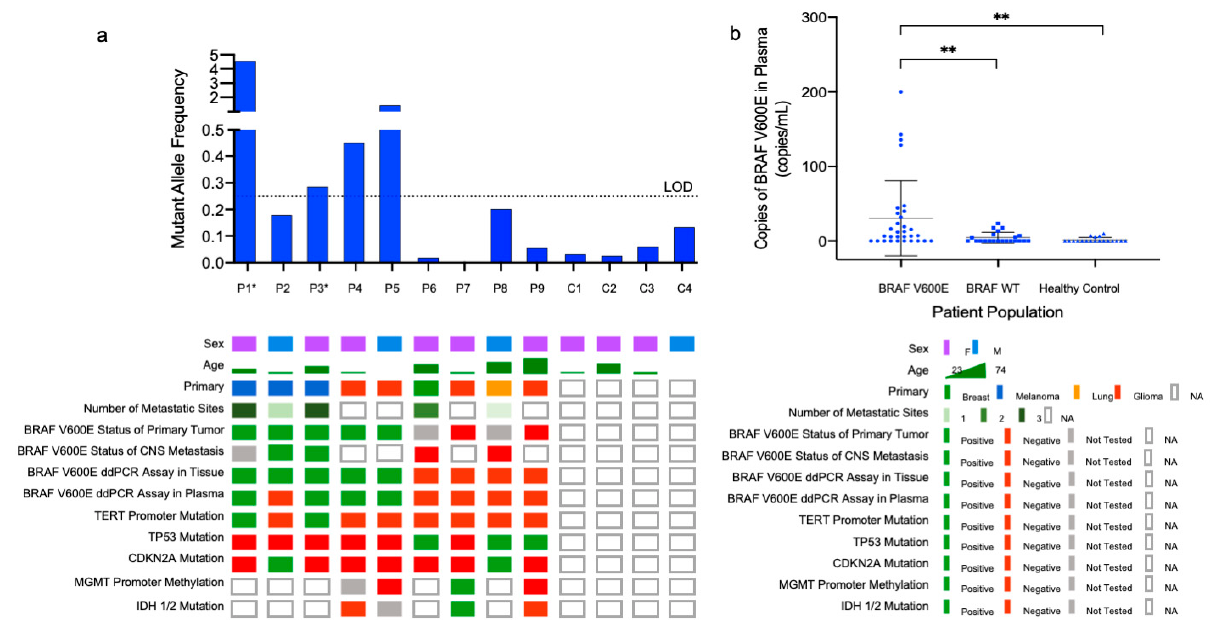
Figure 5. BRAF V600E and BRAF Wild Type ddPCR assay in patient plasma. ( a ) Mutant allele frequency (MAF, %), which is the ratio of BRAF V600E positive events to BRAF WT positive events, as determined by the ddPCR Plasma Assay is shown with respect to patient study IDs. The threshold for positivity, defined as the LOD, 0.285%, is shown as a dotted line. MAF ranged from 0.2–4.5% in patients with known BRAF V600E mutations (P1–5). MAF ranged from 0.0–0.2% and 0.0–0.1% in plasma from patients with known BRAF WT status (P6–9) and healthy controls (C1–4), respectively, thus all 8 known WT samples were defined as negative by the plasma assay. An OncoPrint depicting patient demographics and tumor specific information, including histopathologic testing and mutational statuses, is shown. Patients with available longitudinal samples are denoted by an (*); ( b ) BRAF V600E mutant copies per mL of grouped patient plasma is plotted against known BRAF status, as determined by the ddPCR Tumor Assay. Then, 4 µL of exNA isolated from 2 mL of plasma was used as input for the ddPCR assay with the universal primer set (ddPCR Plasma Assay). p- value ≤ 0.01 indicated by (**).